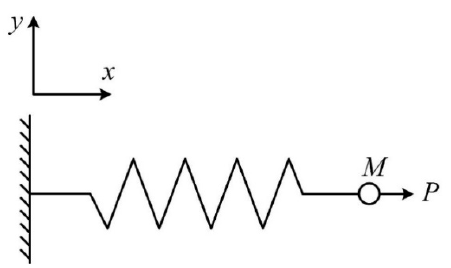
Figure 5. Single-degree-of-freedom system.